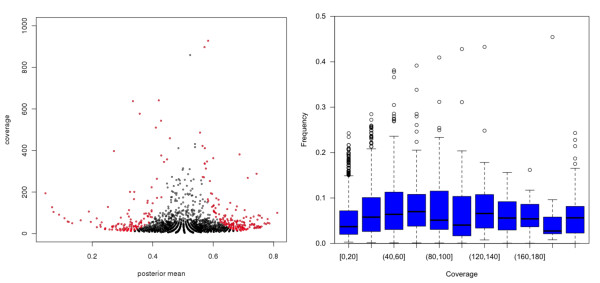
Allele specific expression. a) Coverage versus posterior mean of allele transcription rate (p); each point represents a SNP; red points are SNP showing significant ASE and black points are SNPs with no significant ASE. b) Barplot of coverage versus absolute value of p. It can be seen that there was not a consistent relation between ASE and coverage.